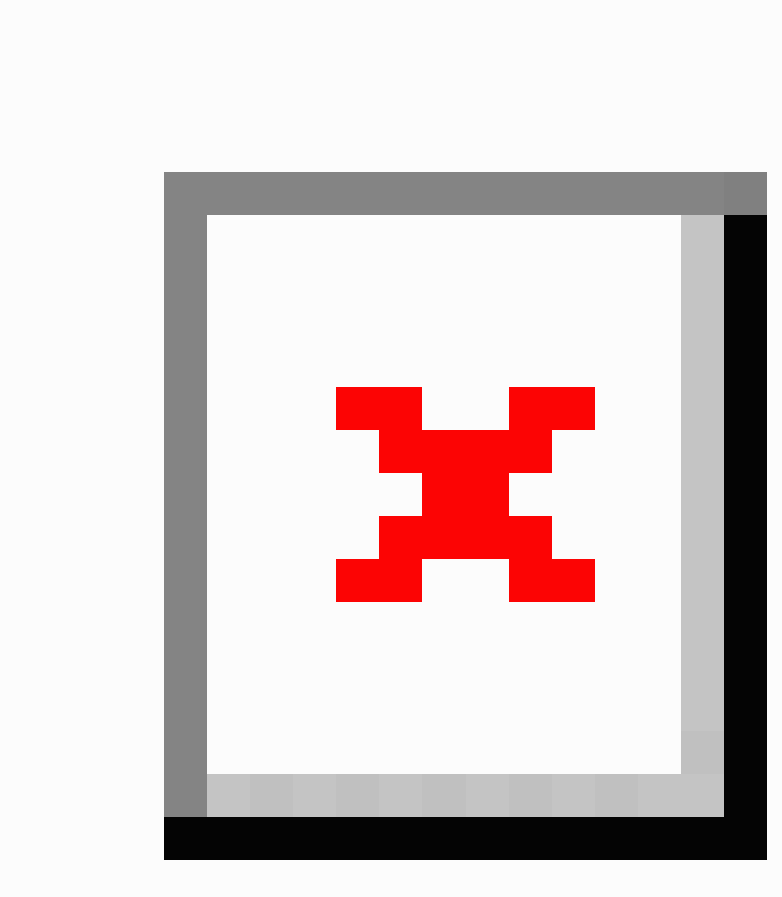
Figure 1. Example of medication homepage before usability